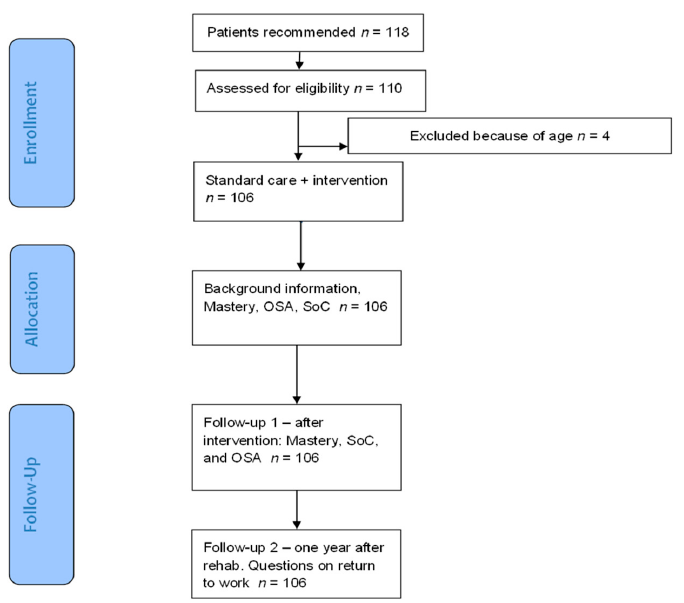
Figure 1. Flowchart. OSA: Occupational Self-Assessment; SoC: Sense of Coherence.